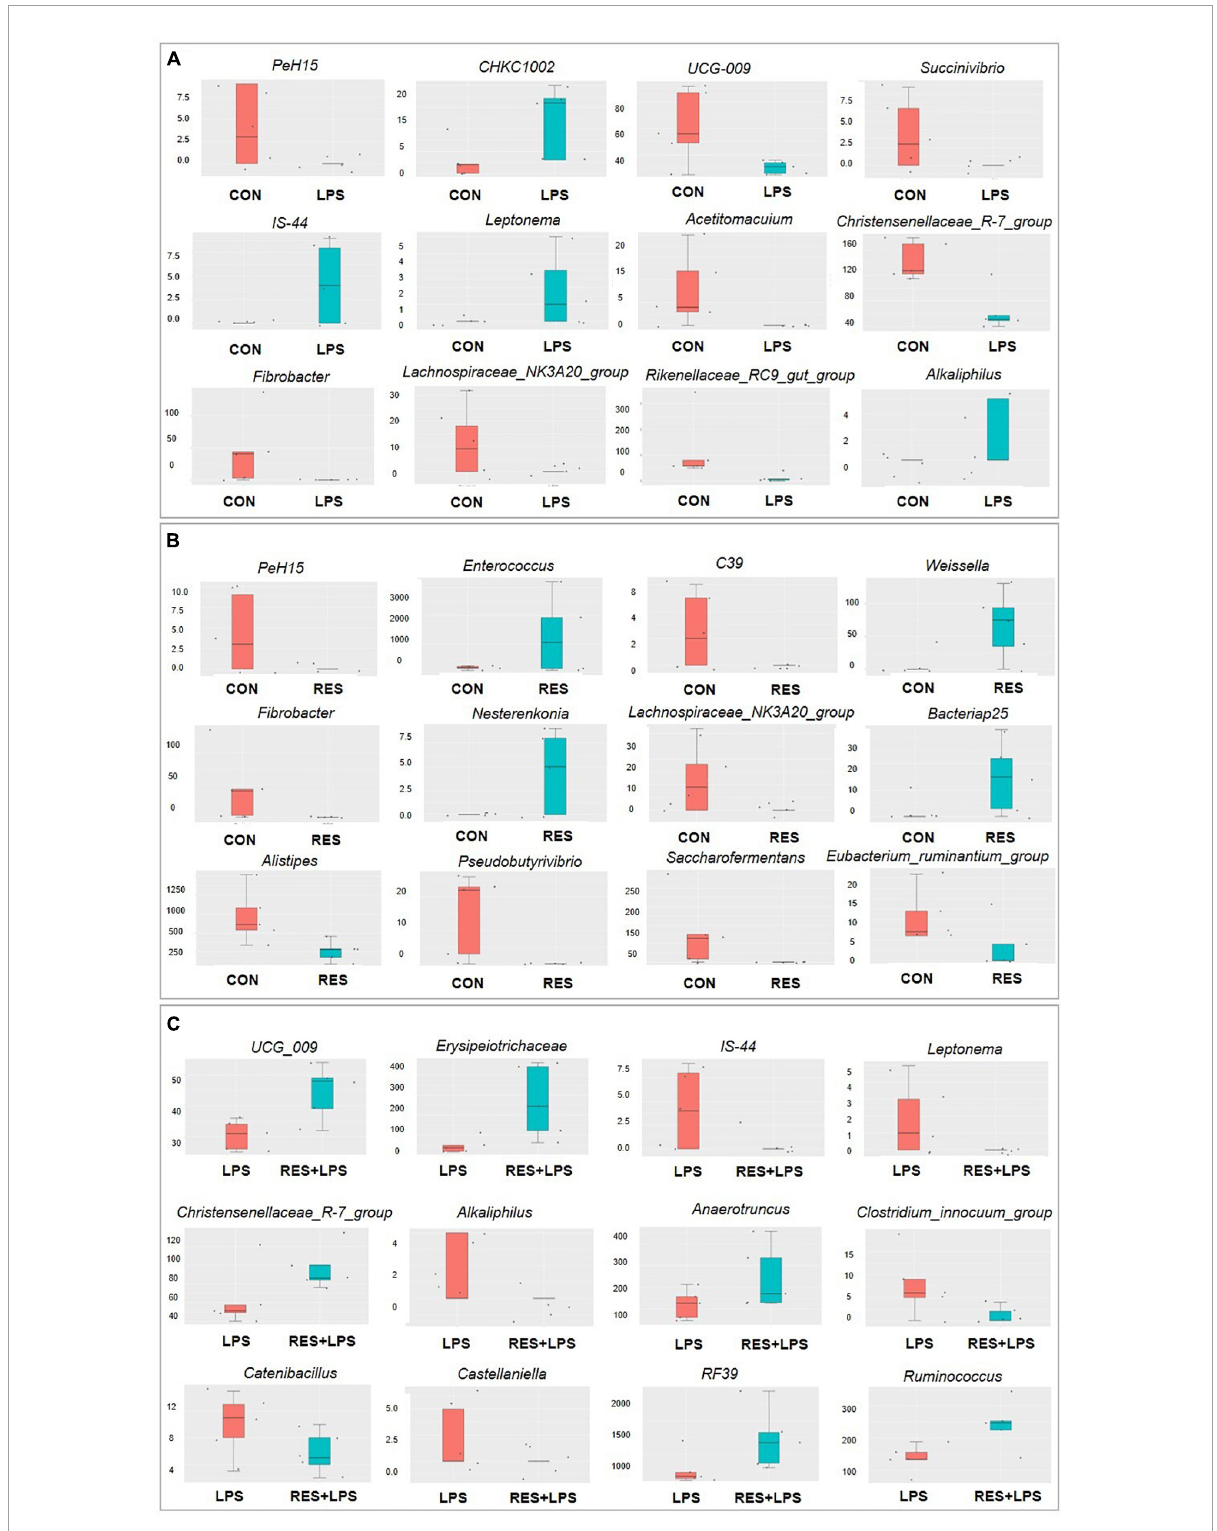
FIGURE6 The Metastat analysis of cecal microbiota between treatments of cecal microbiota changes in yellow-feathered broilers. (A) Control group vs. LPS group. (B) Control group vs. RES group. (C) LPS group vs. RES + LPS group. CON, control; RES, resveratrol; LPS, lipopolysaccharide; RES + LPS, dietary resveratrol treatment followed by LPS